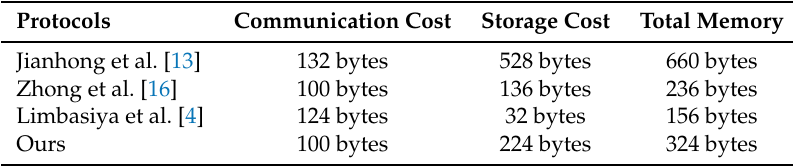
Table 4. Communication cost and storage